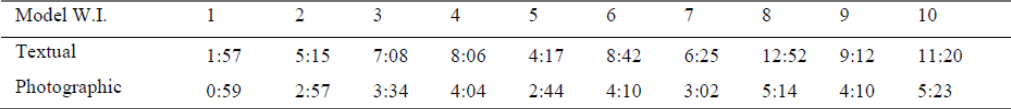
Figure 2: Comparison of time spend to process information from work instructions [8].